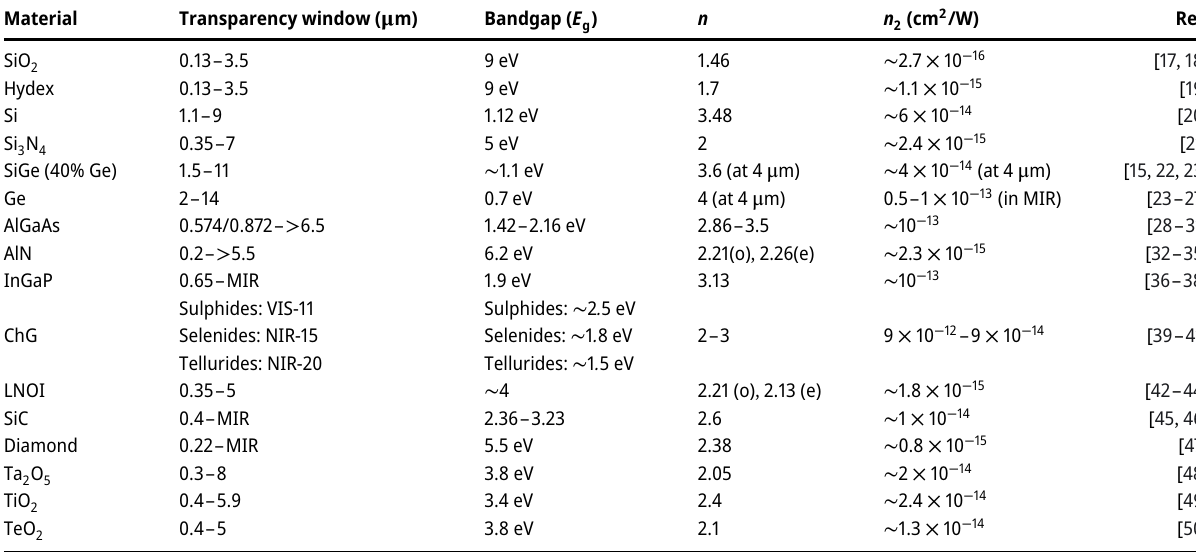
Table 1: Properties of materials used for optical integration. Values of refractive index n , and n 2 , are at 1.55 μ m unless stated otherwise. The transparency window is defined as the band where the absorption loss is below 2 dB/cm.